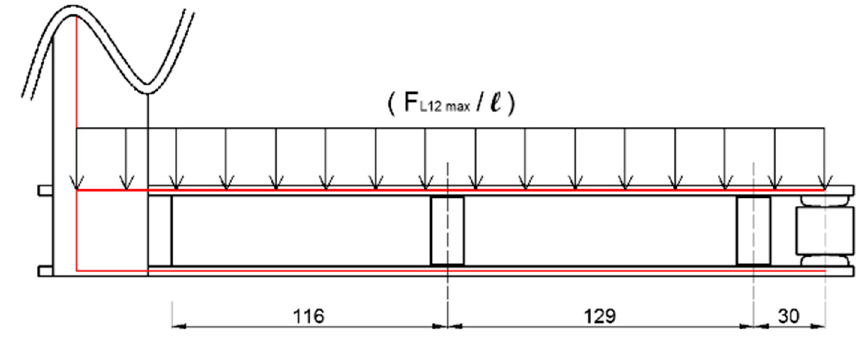
Figure 9. Phase L1—uniformly distributed load on knife L12. Table 4. Stress values for each span.